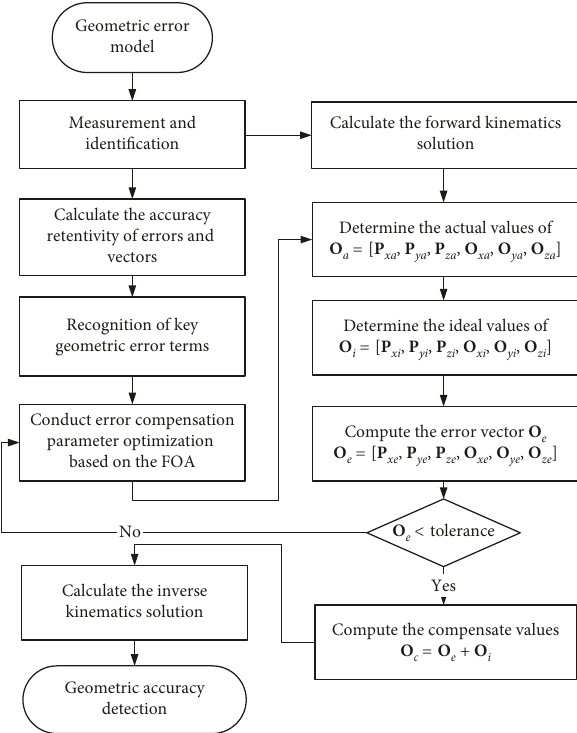
Figure 9: Flow chart of geometric error